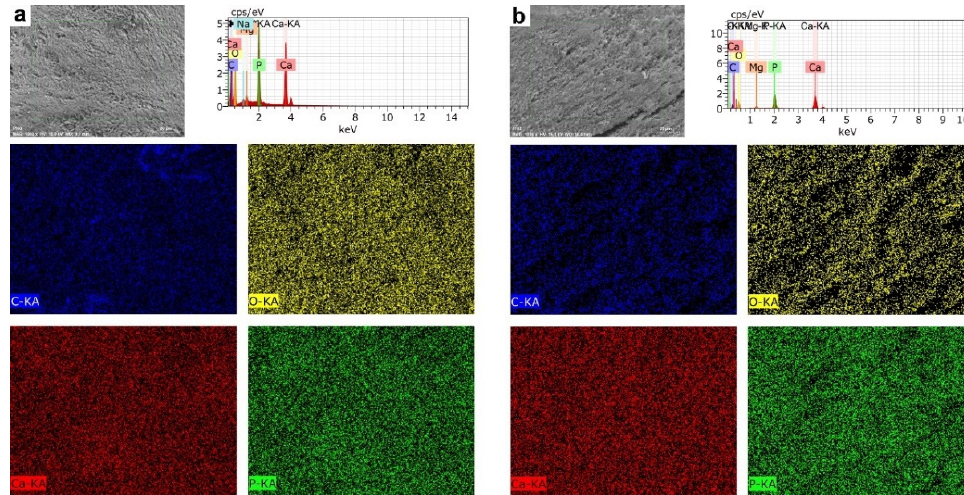
Figure 7. Mapping Elemental Distribution in the jaw bone of rainbow trout (Oncorhynchus mykiss) . ( a ) Farmed fish. ( b ) Wild fish. BSD image, 1000× magnification. Scanning Electron Microscope (Hitachi SU3500, Tokyo, Japan) coupled to XFlash ® Detector 410 and Quantax Esprit 1.8.1 Software controller (Bruker, Germany).